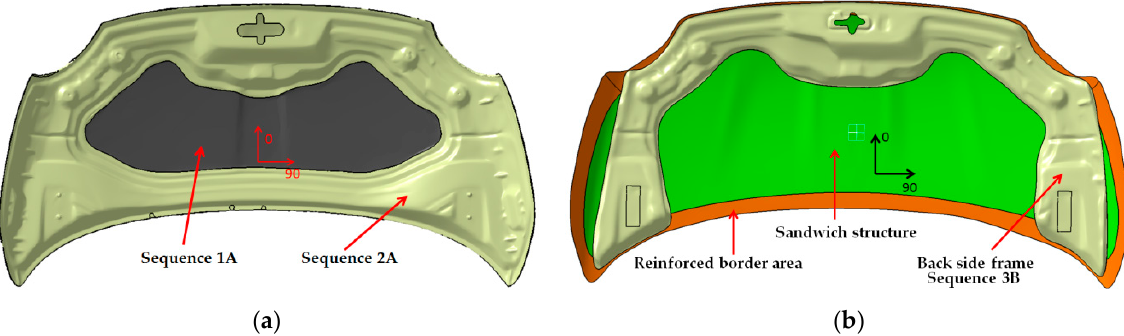
Figure 2. The CAD model of the backside of hoods. The positioning of the CFRP sequences on hood: ( a ) front hood variant “A”; ( b ) front hood variant “B”.